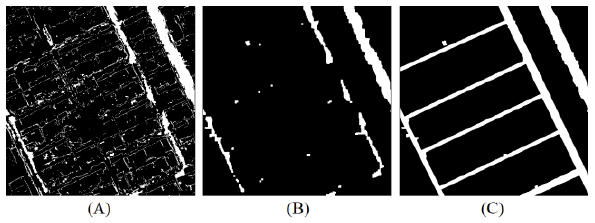
Figure 6. Colonnades vegetation cover extracted using NDVI Water features could be extracted just like vegetation cover.